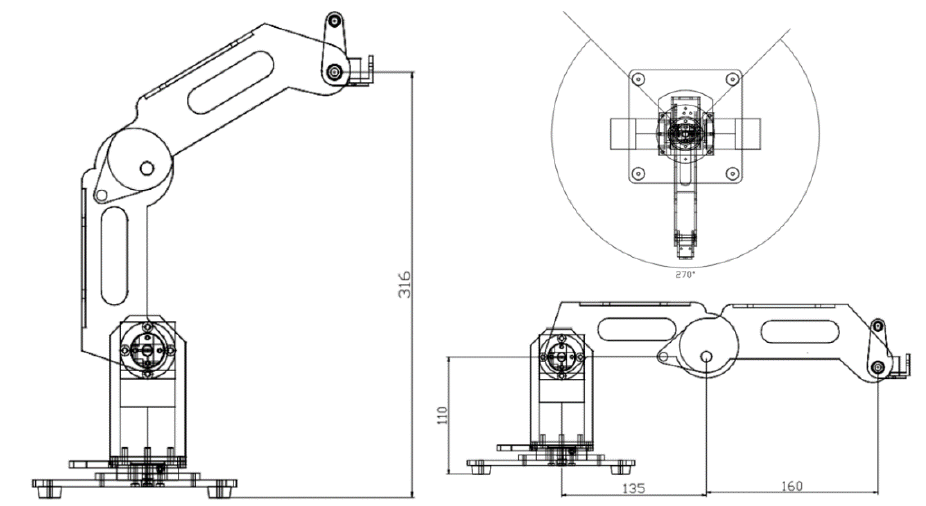
Figure 3. Structure diagram of the manipulator.